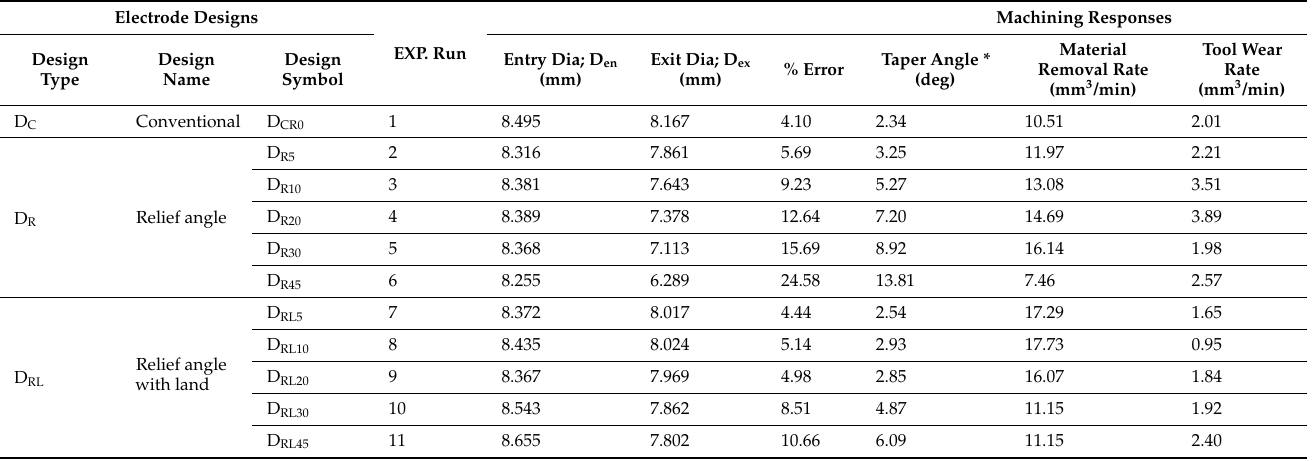
Figure 4. Microscopic images of the machined holes at the entrance and exit sides corresponding to stage-1 of experimentation. Table 4. Machining results of stage-1 of